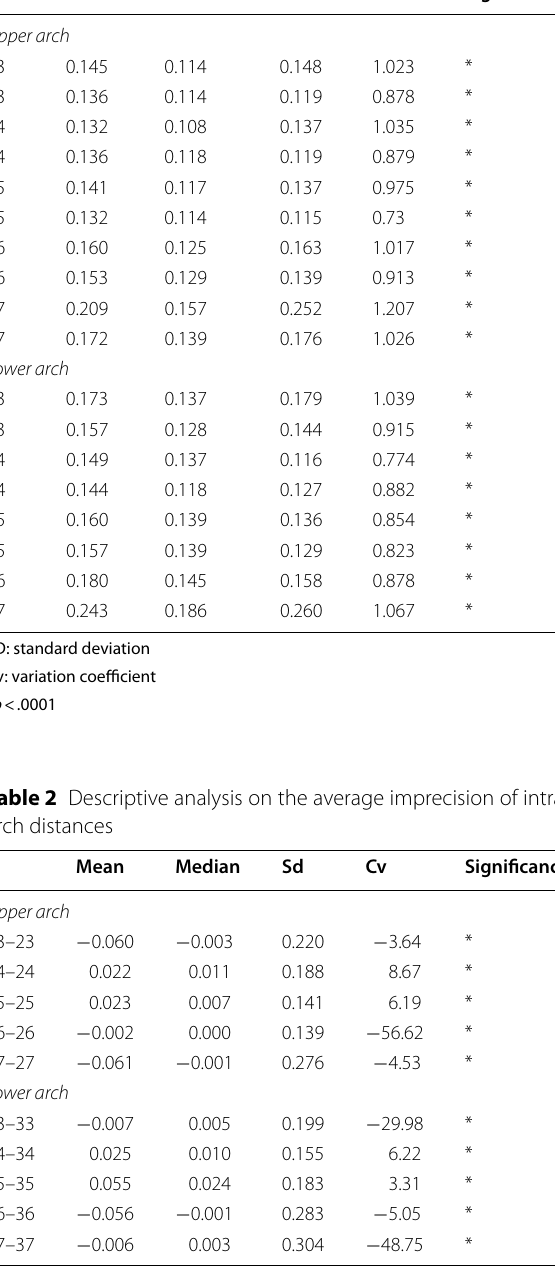
SD standard deviation